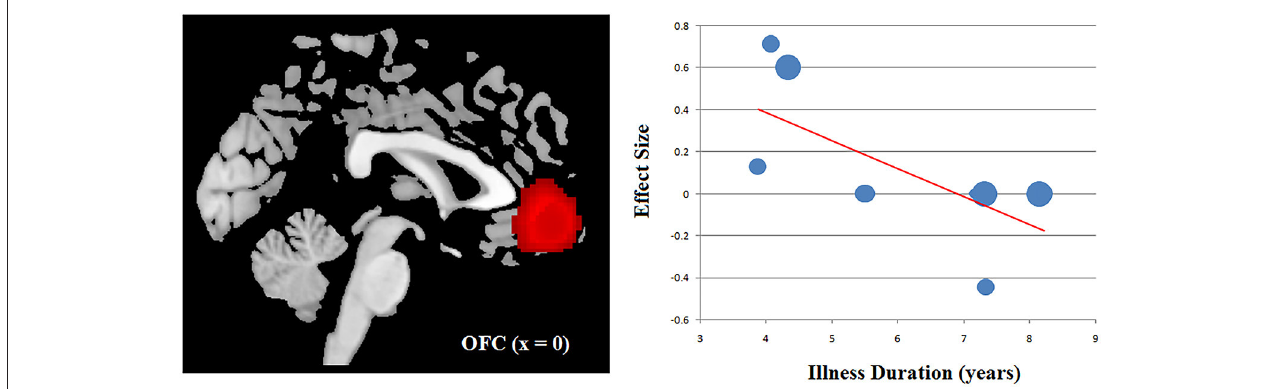
FIGURE 3 | Results of meta-regression analysis illustrating a negative association between the ReHo in the OFC and the illness duration in patients with OCD. The effects sizes were extracted to create the plots in the graph and each study is represented as a dot, with dot size reflecting sample size: large dots indicate samples with over 40 patients; medium dots, samples with 20–40 patients; and small dots, samples with under 20 patients. OCD, obsessive-compulsive disorder; OFC, orbitofrontal cortex; ReHo, regional